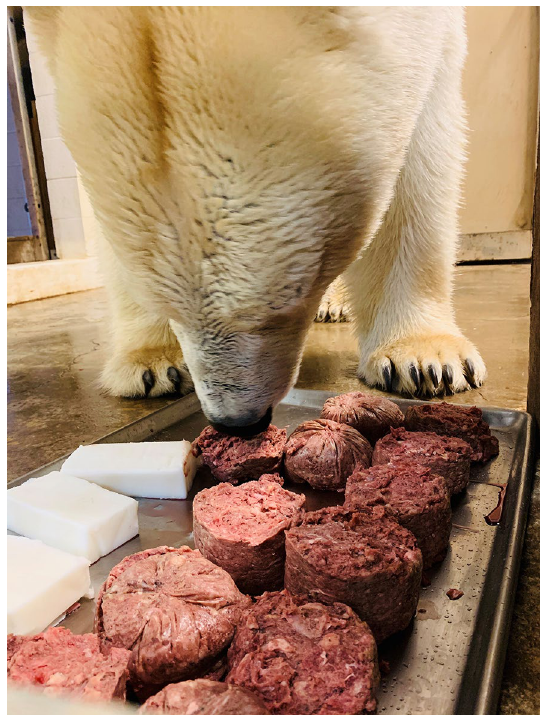
Figure 3. A female polar bear at the Columbus zoo selects among lean meat and lard food options (Photo c/o Devon